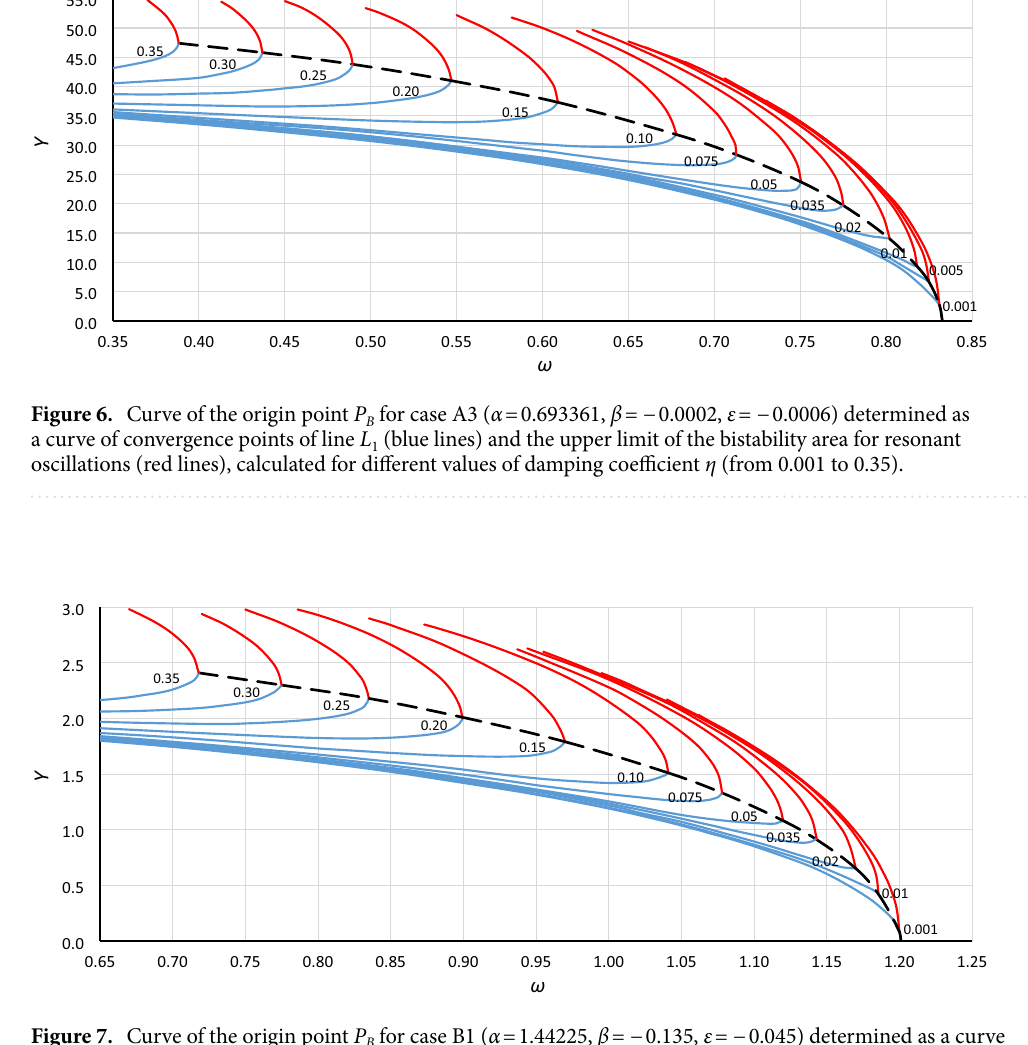
Figure 7. Curve of the origin point P B for case B1 ( α = 1.44225, β = − 0.135, ε = − 0.045) determined as a curve of convergence points of line L 1 (blue lines) and the upper limit of the bistability area for resonant oscillations (red lines), calculated for different values of damping coefficient η (from 0.001 to